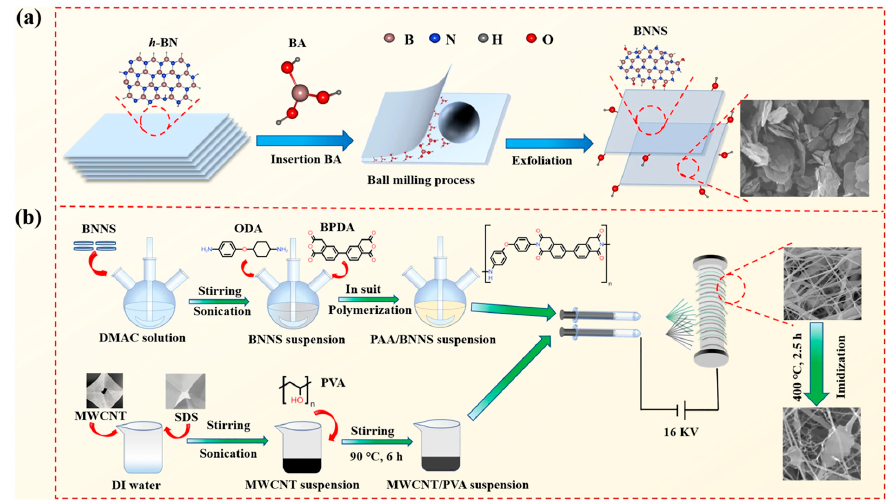
Figure 12. Schematic illustration for the ( a ) exfoliation of BNNS and ( b ) fabrication of PI/BNNS/CNT@ α PVA membranes. Reprinted with permission from Ref. [93]. 2021,